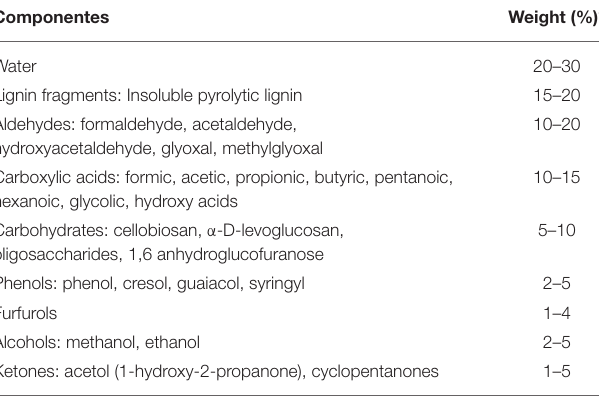
TABLE 1 | Chemical composition of